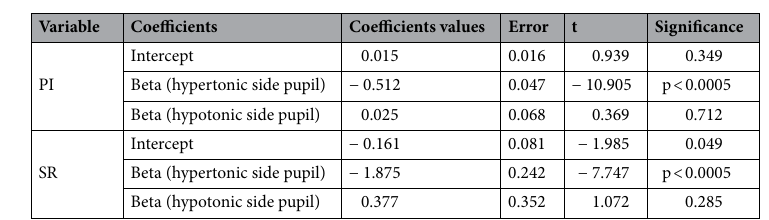
Table 4. Multiple correlation model of the relation between PI (performance index) and SR (scanning rate) changes with pupil size changes on the hypertonic and the hypotonic side. Note the low value of the beta coefficient for the hypotonic side pupil and its lack of